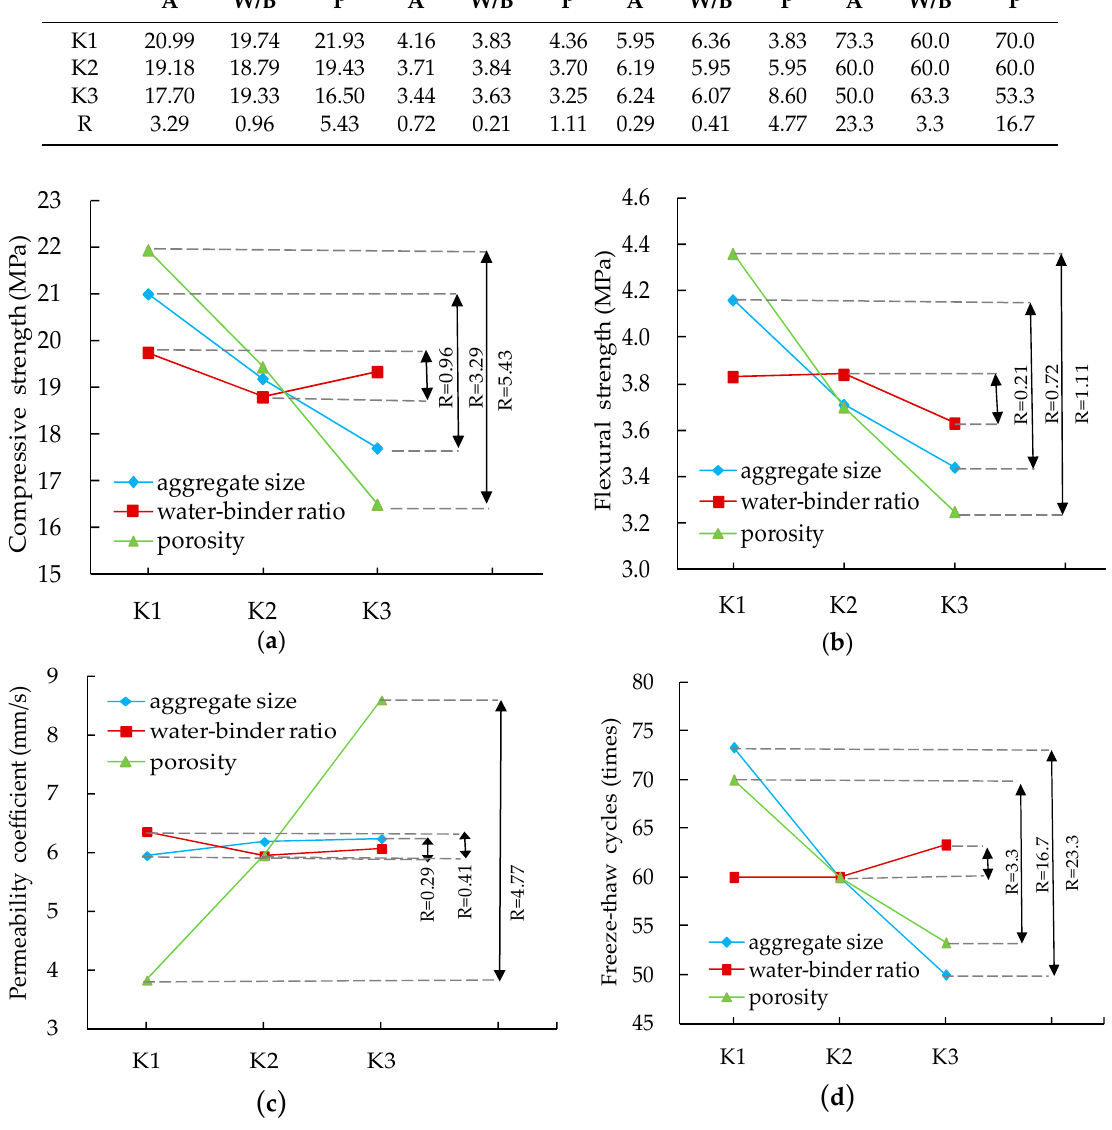
Figure 3. Relationships between various property indices and K values: ( a ) between compressive strength and K; ( b ) between flexural strength and K; ( c ) between permeability coefficient and K; ( d ) between freeze-thaw cycles and K. Table 5. Range analysis results; A: aggregate size; W/B: water-binder ratio; P: porosity